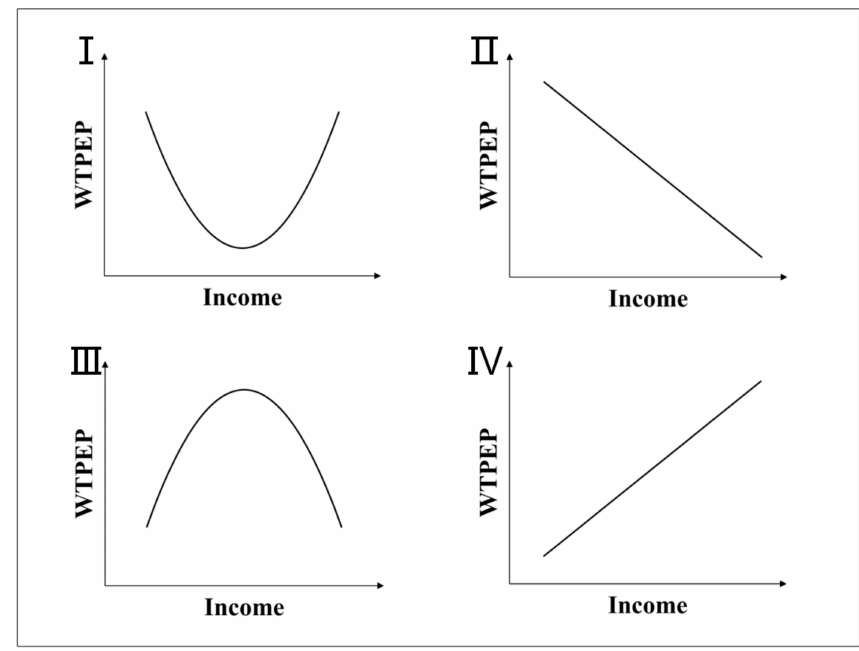
Figure 2. Various EKC characteristics between WTPEP and income